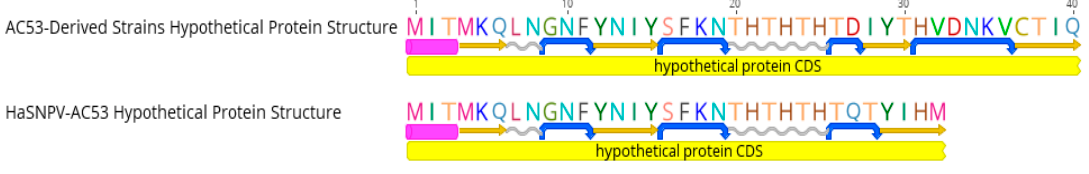
Figure 2. Amino acid sequence and predicted protein structure of hypothetical proteins identified using the EMBOSS garnier [63]. Alpha helix (purple rectangle), beta strands (yellow arrows), coils (gray wavy lines), and the turns (blue curved arrows) are depicted here. AC53-derived strains contain an additional turn and an additional beta strand; CDS, coding DNA sequence.